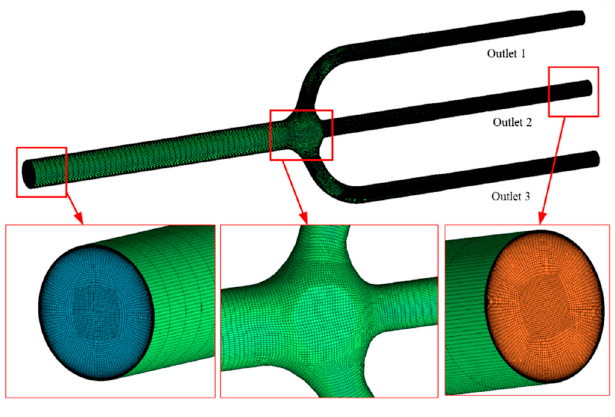
Figure 4. Grid for model. Figure 4. Grid for